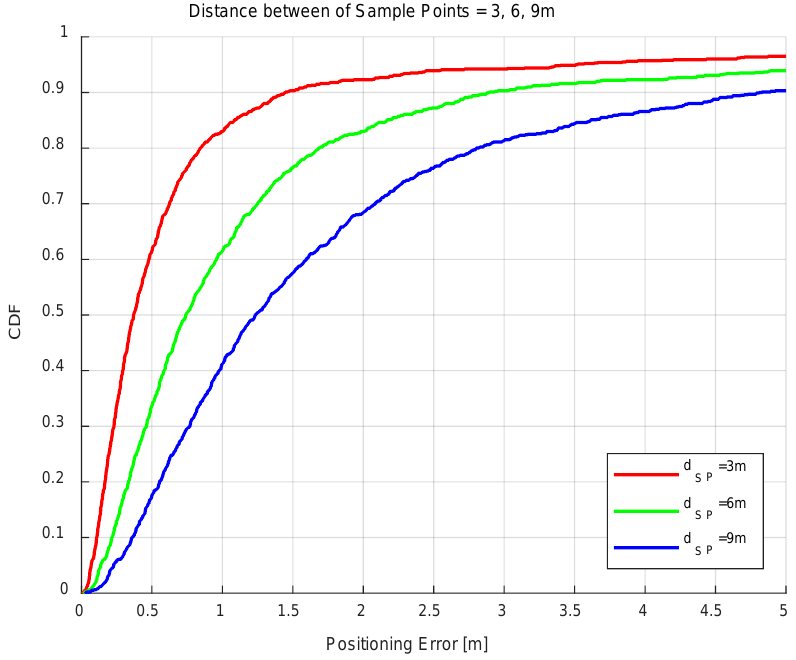
Figure 9. Positioning error CDF according to distance between SPs.